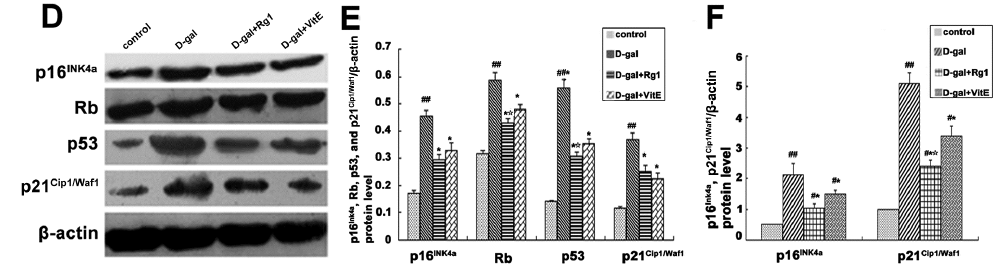
Figure 6. Effects of ginsenoside Rg1 on r-H2A.X, 8-OHdG, p16 Ink4a , Rb, p53, p21 Cip1/Waf1 , p16 Ink4a mRNA, and p21 Cip1/Waf1 mRNA expressions of Sca-1 + HSC/HPCs from D -gal-induced aging mice. ( A ) The r-H2A.X expression is shown by Western blot analysis. β -actin was the internal control; ( B ) Quantification of r-H2A.X expression is shown. The r-H2A.X expression was significantly up-regulated in the D -gal group compared with the other three groups ( ## p < 0.01, * p < 0.05); ( C ) The 8-OHdG levels in the mice serum in each group were measured using an ELISA kit. Data are expressed as the means ˘ SD. The experiments were performed five times; ( D ) The p16 Ink4a , Rb, p53, and p21 Cip1/Waf1 expressions are shown by Western blot analysis. β -actin was the internal control protein; ( E ) Quantification of p16 Ink4a , Rb, p53, and p21 Cip1/Waf1 protein levels is shown.